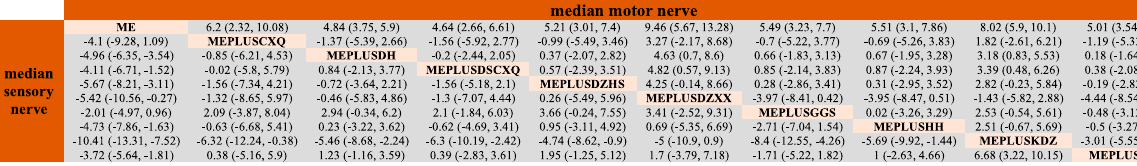
TABLE 4 Network meta-analysis of median nerve.